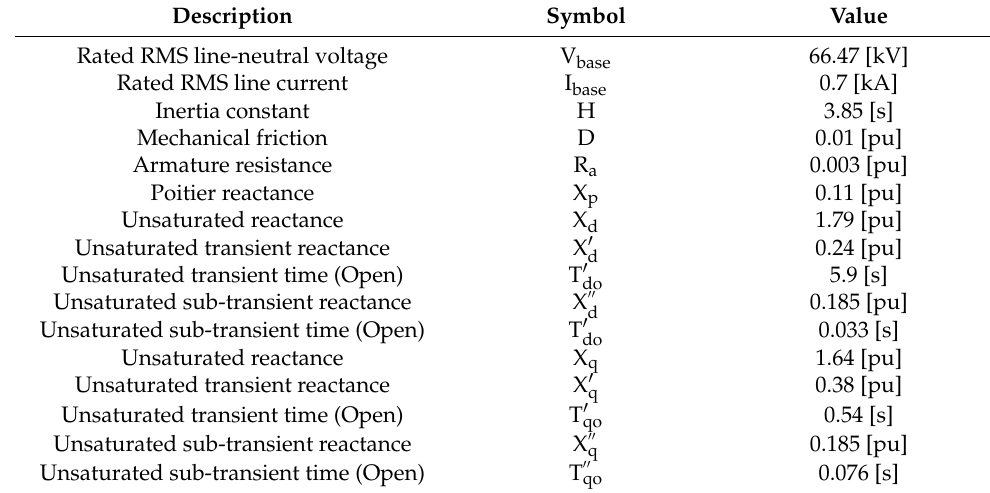
Table 2. Parameters of 6th model of synchronous generator.